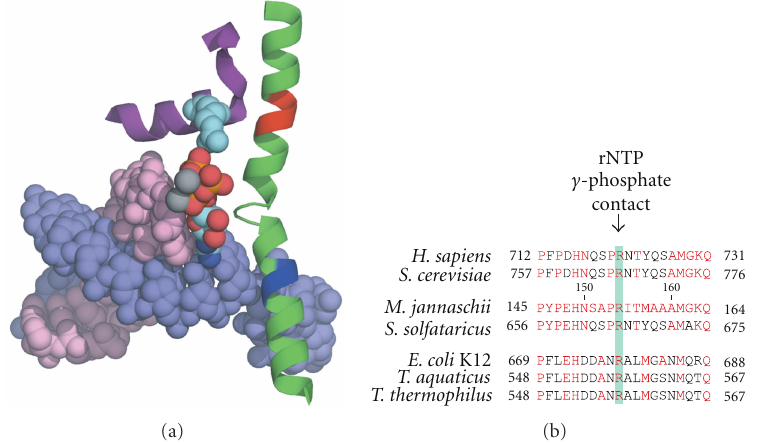
Figure 2: The Link domain. (a) Arrangement of the Bridge Helix and Link domain relative to the nucleotide insertion site. The Link domain (purple) and Bridge Helix domain (green) are shown as cartoon structures using the same coloring scheme as in Figure 1(b). The nucleic acid substrates are depicted in space-filling mode. Note the contacts made by the rNTP γ -phosphate (phosphate atoms in orange and oxygen atoms in red) with sc RPB2 R766 (shown in space-filling mode, light blue). (b) Alignment of Link domain sequences from the same species shown in Figure 1(c). The invariant arginine (R) is highlighted with a light green bar.